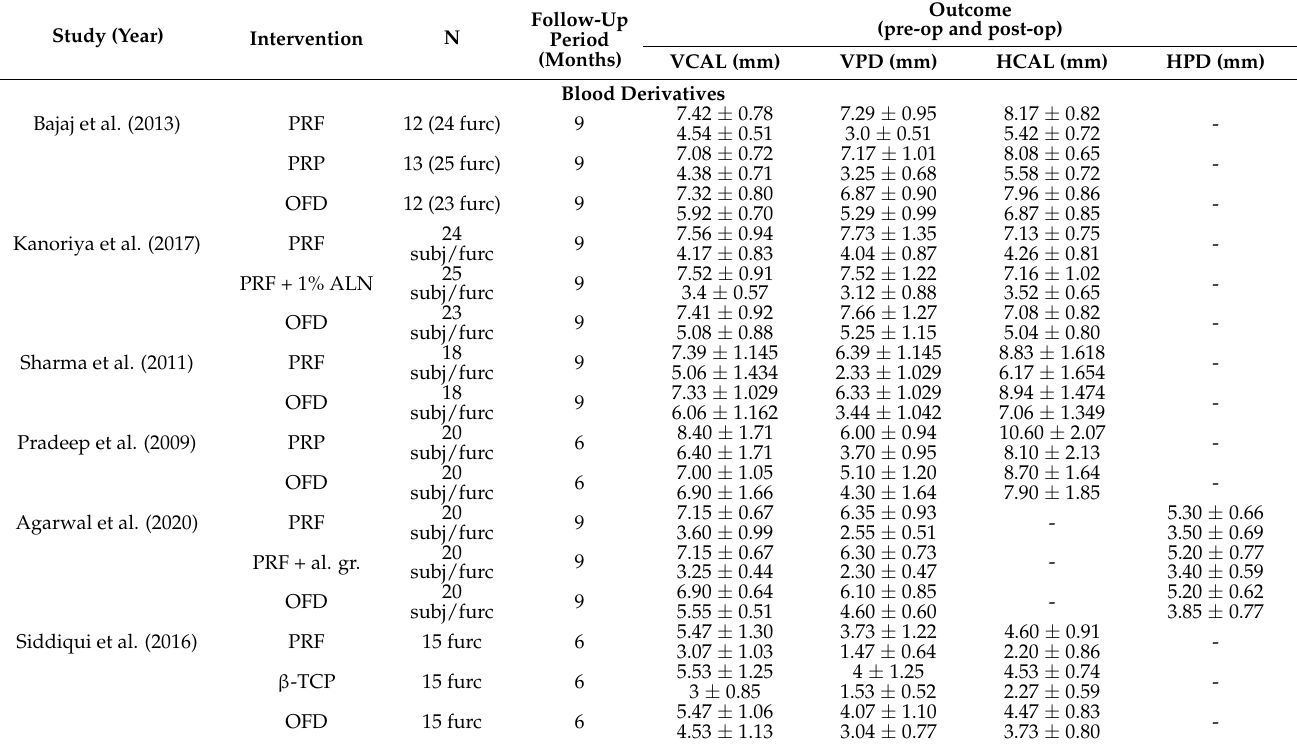
Table 5. Results reported at baseline and at follow-up in papers where blood derivatives were used.